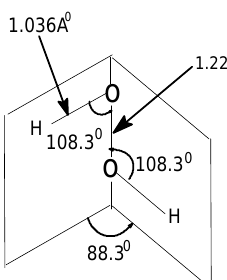
Figure 1. The optimized equilibrium geometry of H